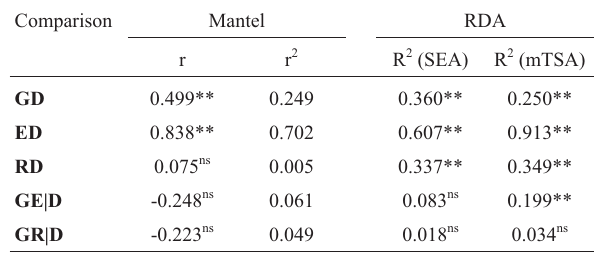
Table 2 - Summary of Mantel and partial Mantel tests applied to “Baru” populations, comparing effects of geographic distance ( D ), environmental variables ( E ) and natural remnants ( R ) into genetic divergence ( G ) esti- mated by pairwise F ST . Results include Mantel’s correlation r (and r 2 , for facility of comparison with RDA results). Also provided are the R 2 of Re- dundancy Analysis (RDA), incorporating geographic space by spatial eigenfunction analysis (SEA) and linear multivariate trend surface